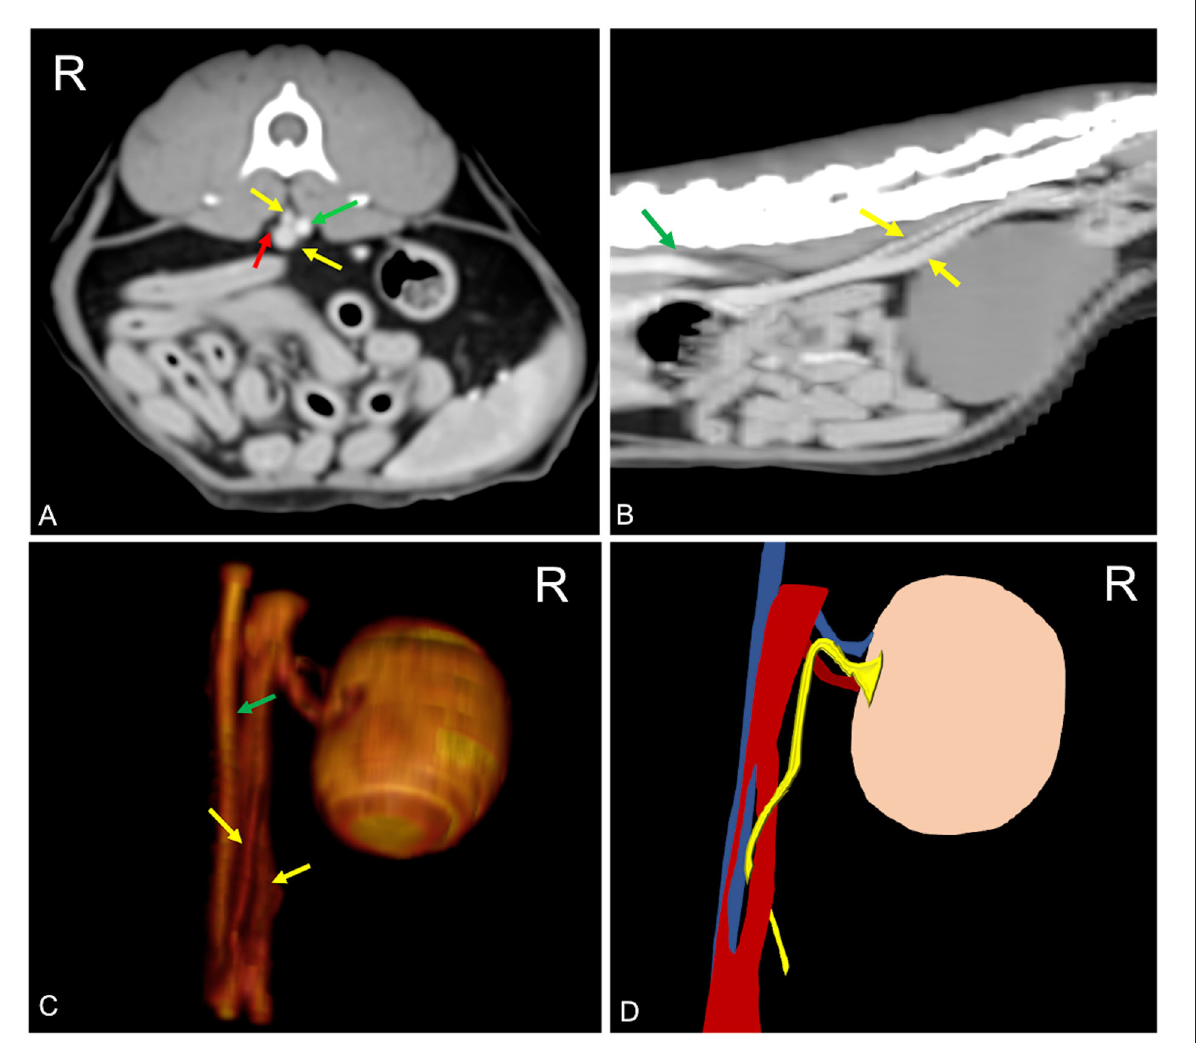
FIGURE3 Postcontrast computed tomographic of mid abdomen in transverse (A) , sagittal (B) , volume rendering image in a right-dorsal view, (C) and schematic representation of the malformation (C) showing the CVC venous ring (yellow arrow) described as double barrel-gun sign with the right ureter (red arrow) passing through it. The two branches of the venous ring appear asymmetric with the dorsal branch located dorsally to the aorta (green arrow). Soft tissue reconstruction (window level: 50 HU, window width 350 HU) and a slice thickness of 2.5mm were used. In (D) , the aorta is blue, the CVC is red, and the ureter is yellow. R,